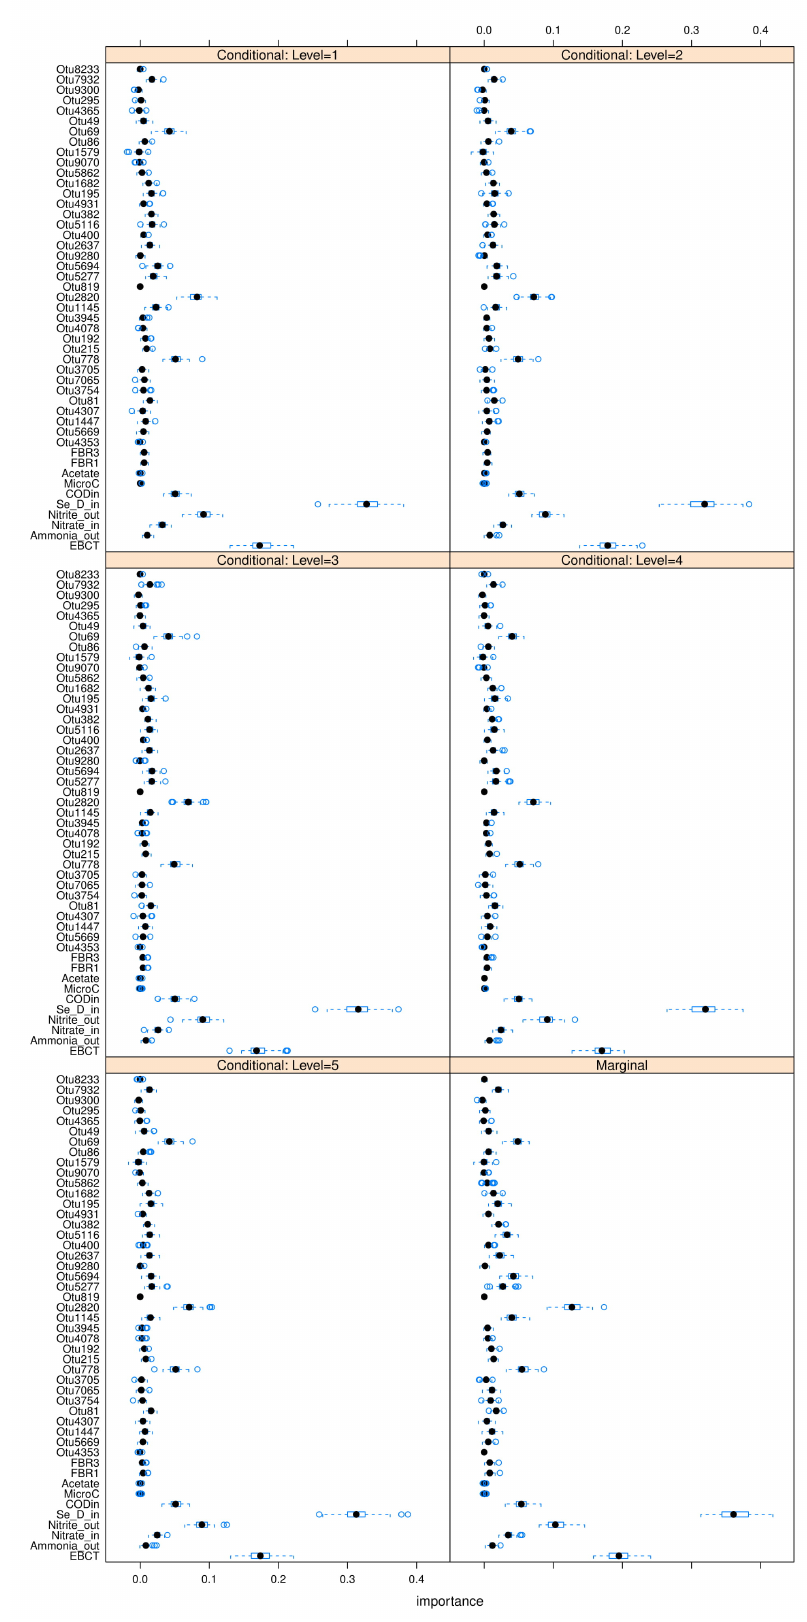
Figure A23. Conditional feature importances for hierarchical